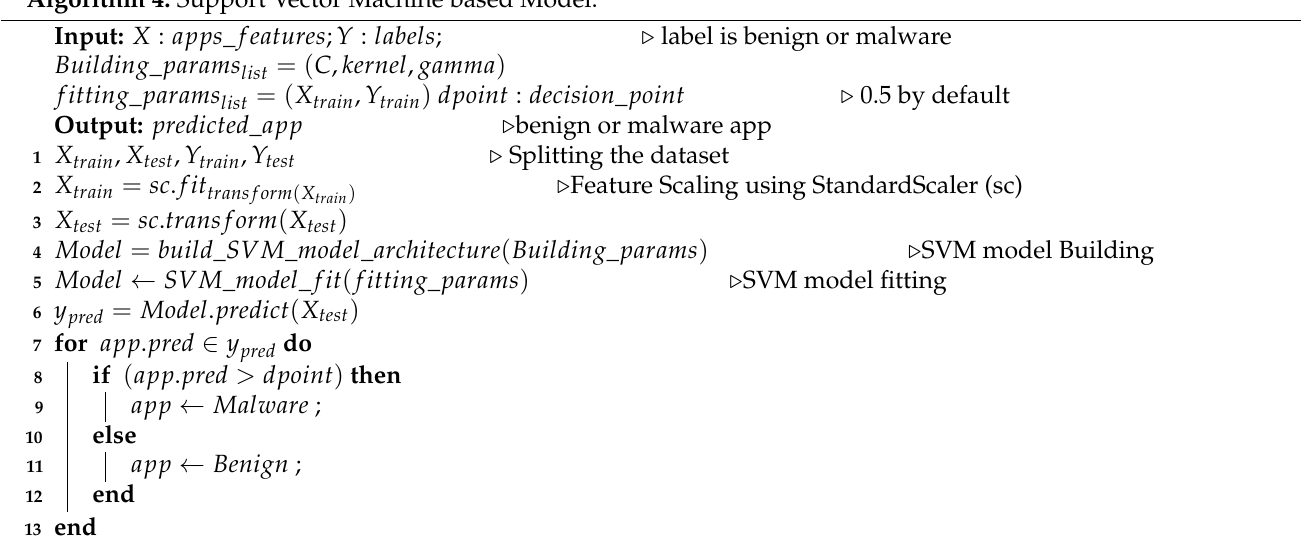
Algorithm 4: Support Vector Machine based